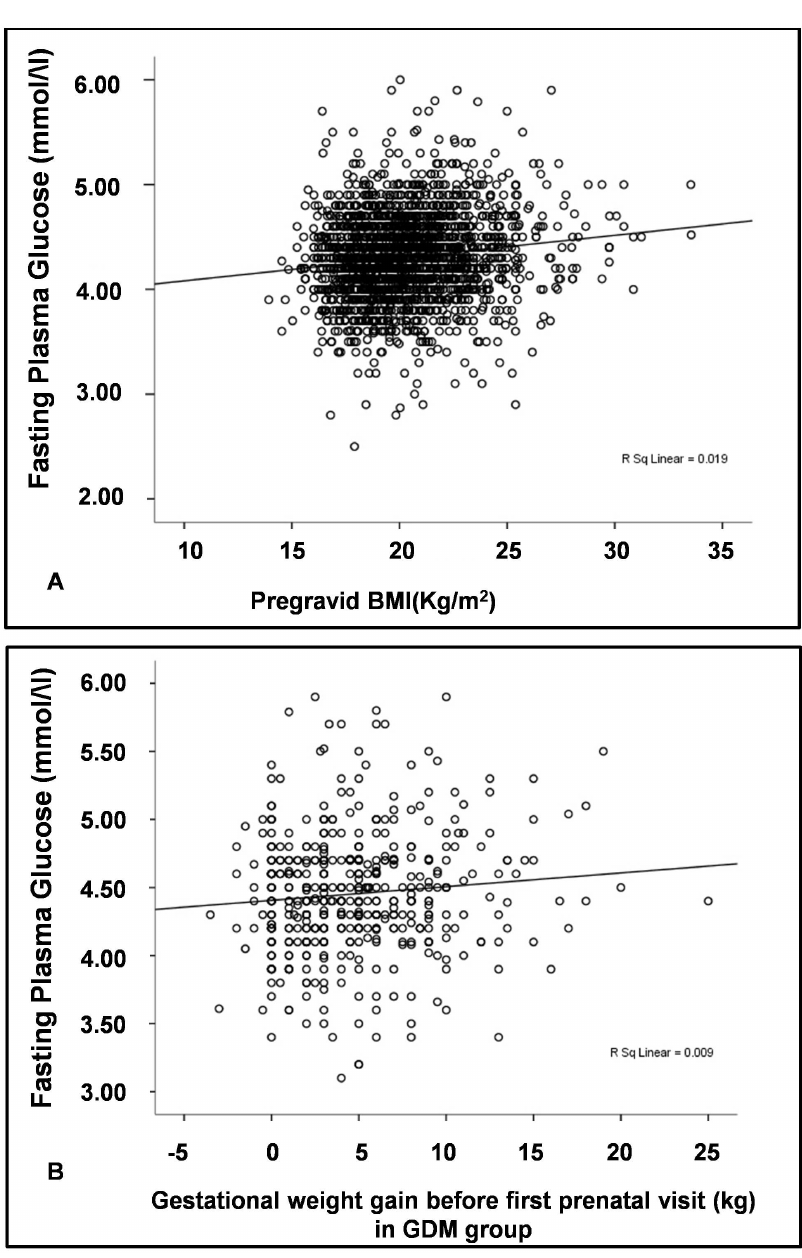
Fig. 3. Relationship between fasting plasma glucose concentration, pre-gravid BMI and weight gain before FPG test. Panel A. FPG is associated with pre-gravid BMI across the tested population. Panel B. FPG is associated with weight gain before FPG test in GDM